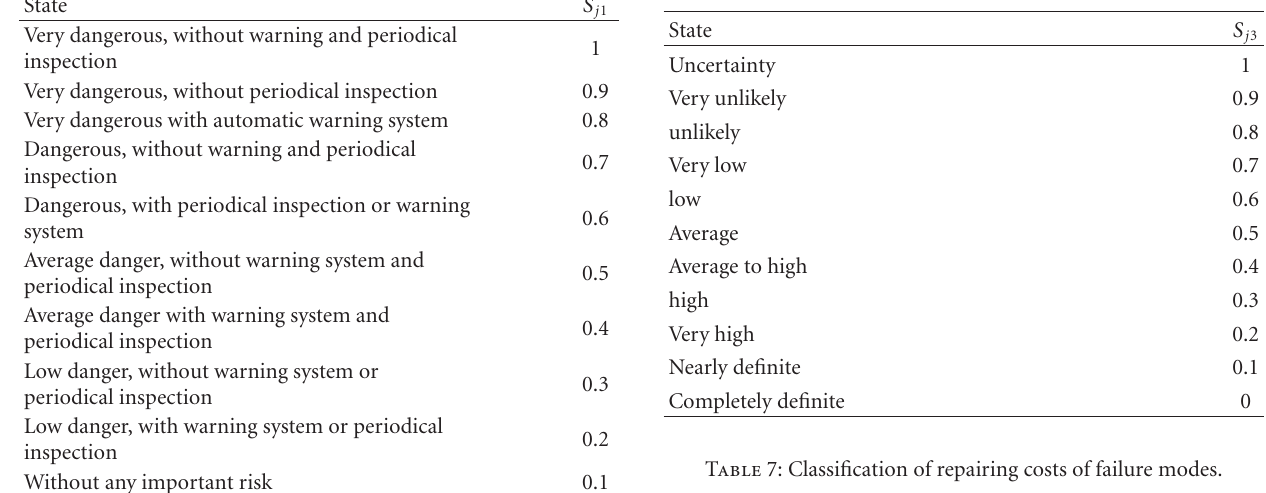
Table 6: Classification of detection and identification of failure modes.